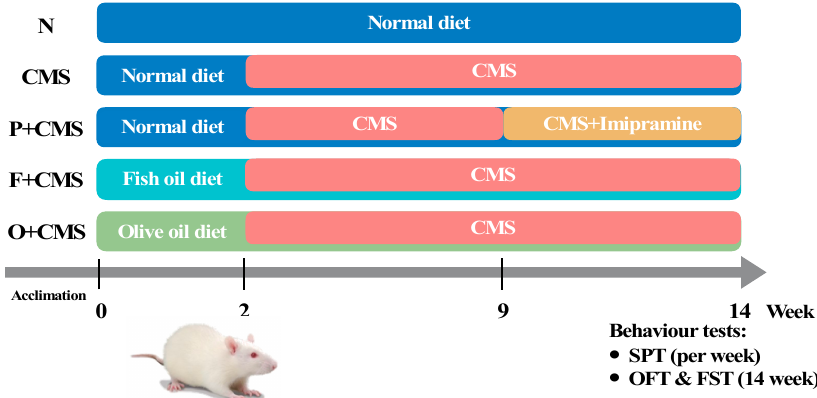
Figure 1. Experimental flow chart. Experimental animals were divided into five groups. CMS—chronic mild stress; SPT—sucrose preference test; OFT:—open field test; FST—forced swimming test.